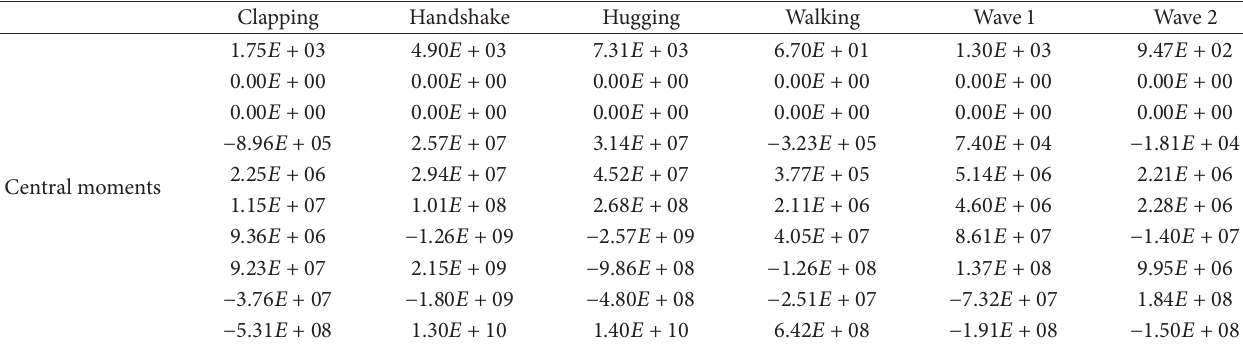
Table 2: The numerical comparison of central moments for each of the actions. Clapping